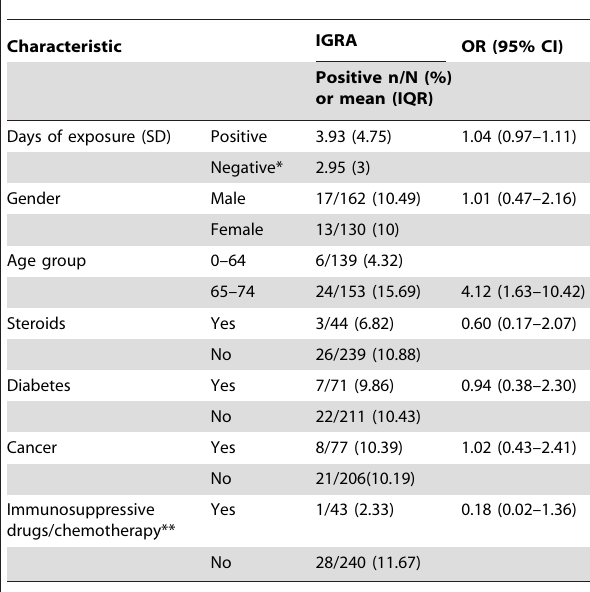
Table 2. Odds ratios and p-values for selected demographic and clinical factors of patients with a determinate interpretative IGRA results (n